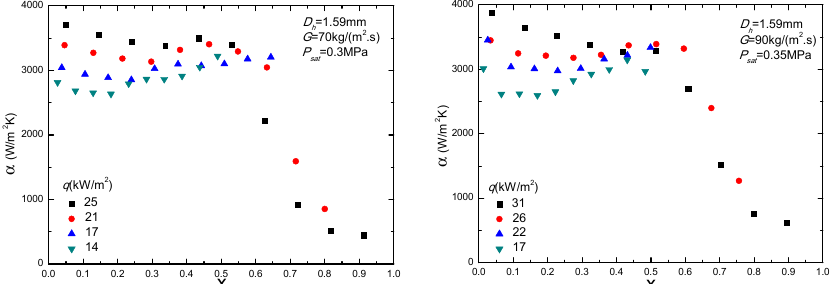
Figure 5. Effect of heat flux on the heat transfer